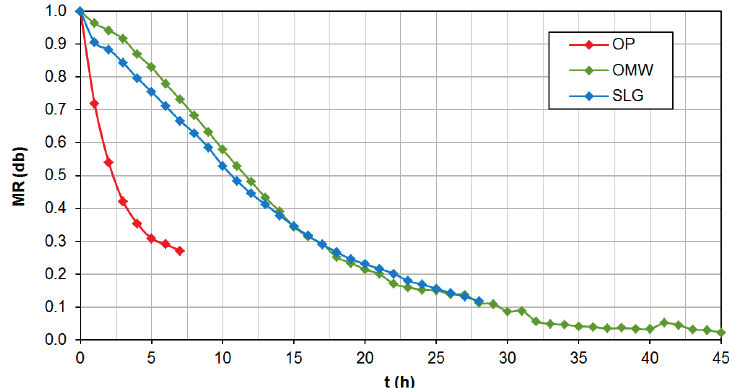
Figure 2. Moisture ratio ( MR ) (db) indirect active mode.